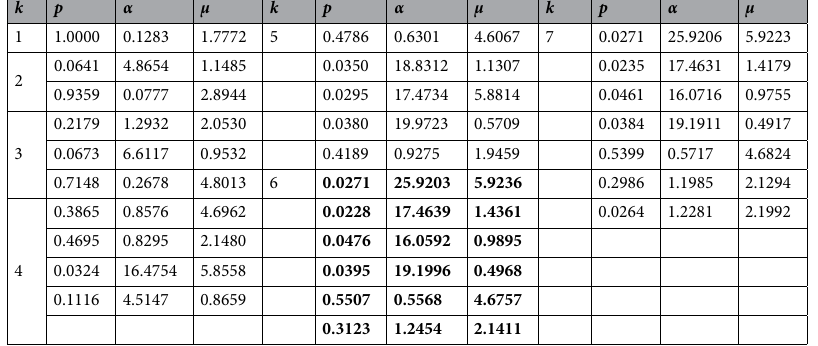
and 5.9236 rad (28.46°, 56.69°, 82.28°, 122.68°, 267.90° and 339.40°), respectively. Compared with the nine main wind directions (0.06°, 31.77°, 76.87°, 91.61°, 122.94°, 130.94°, 174.21°, 251.38° and 323.55°) without considering